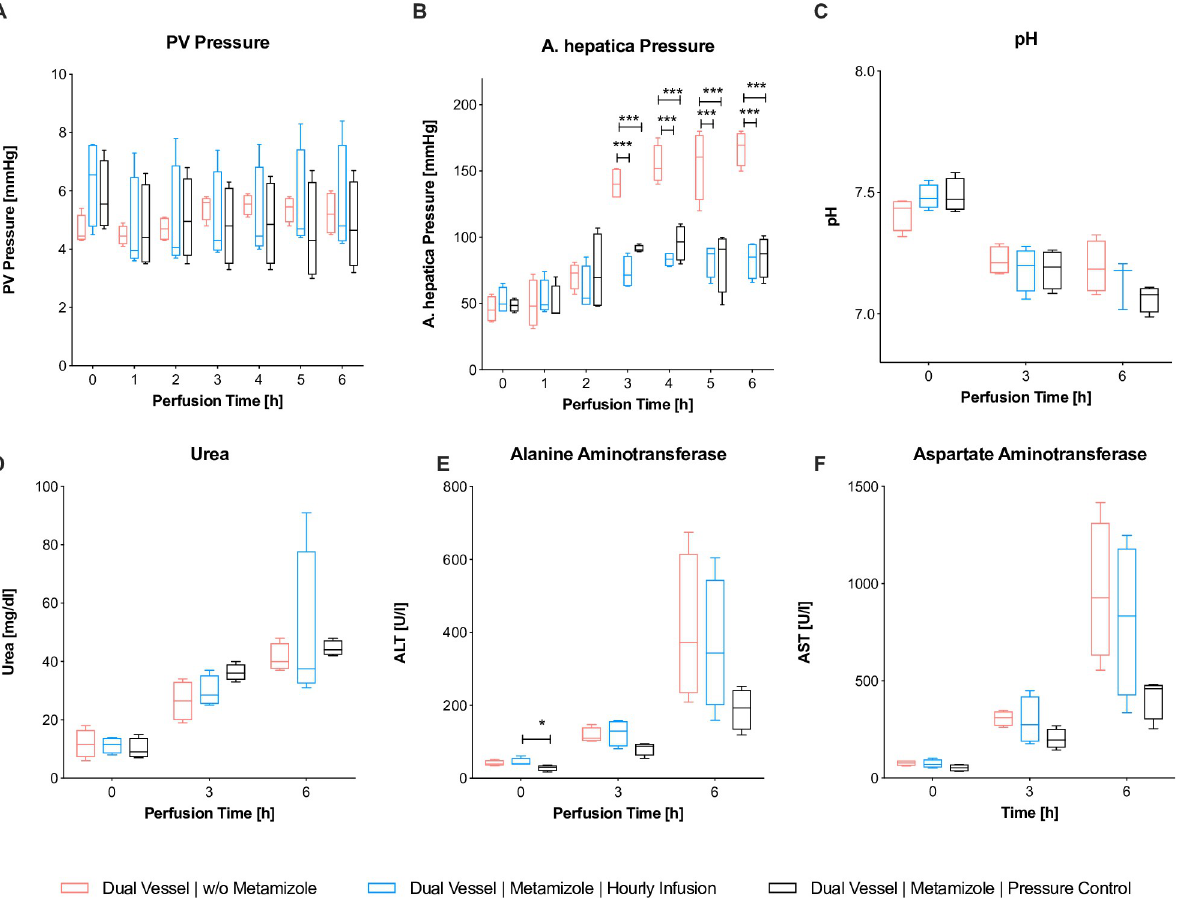
Fig 2. Comparison of dNEVLP groups 1. Comparison of the three dNEVLP groups: (A) portovenous pressure, (B) arterial pressure, (C) perfusate pH, (D) perfusate urea, (E) perfusate alanine aminotranferase, (F) perfusate aspartate aminotransferase. ��� indicates p � 0.001. Data shown as median and interquartile